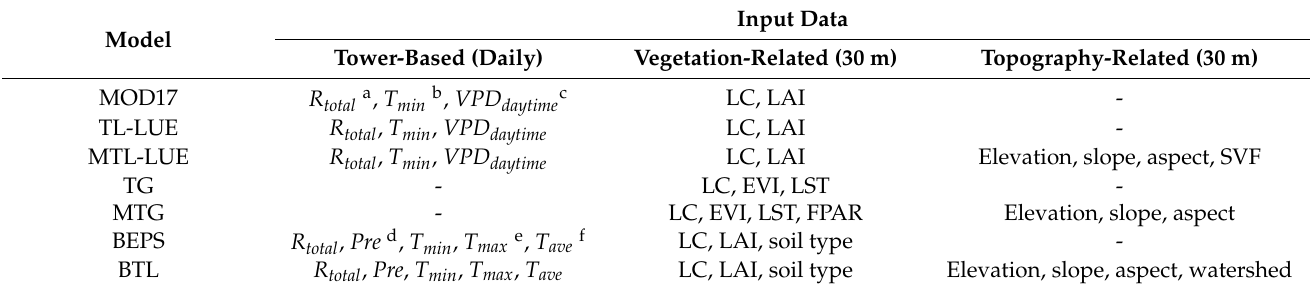
Table 2. Main input data of MOD17, TL-LUE, MTL-LUE, TG, MTG, BEPS, and BTL.